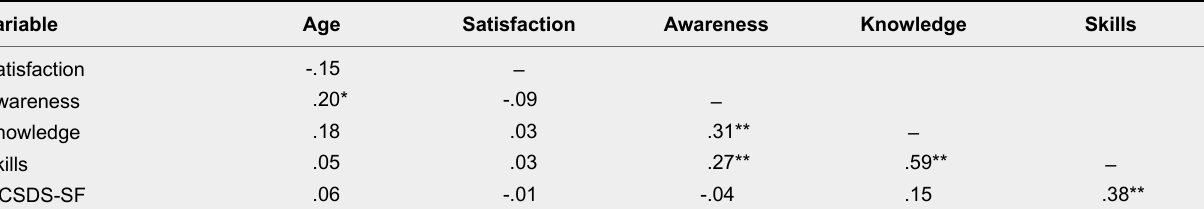
Correlations Between the Study Variables (n = 106) Variable Age